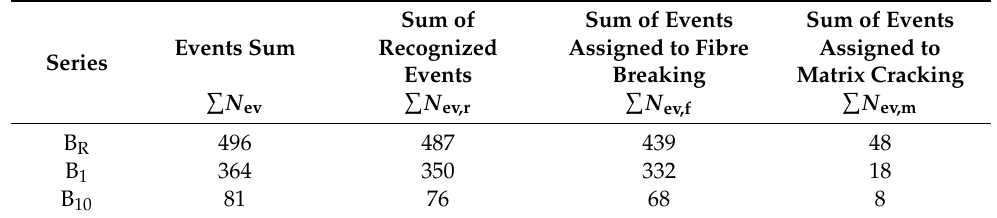
Table 5. Events recognized as accompanying fibre breaking and cement-matrix cracking for boards of series B R –B 10 .